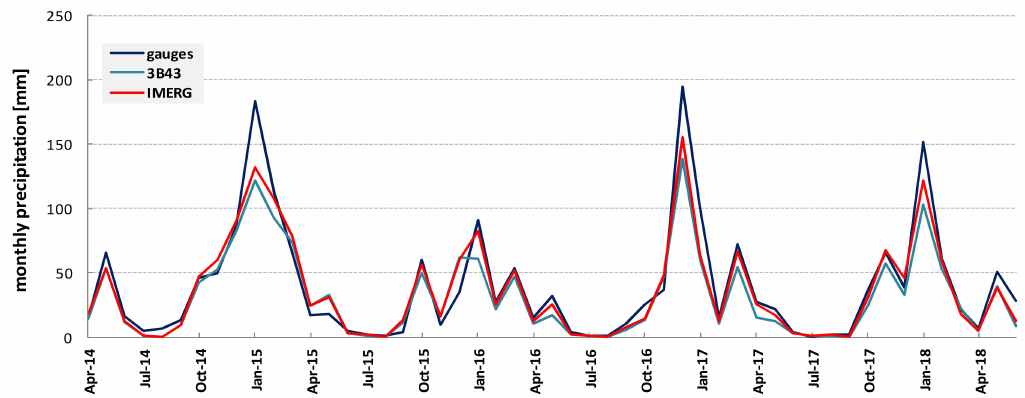
Figure 3. Average monthly values calculated for gauges (dark blue) TRMM 3B43 estimates (light blue) and IMERG estimates (red line) for the period April 2014 to June